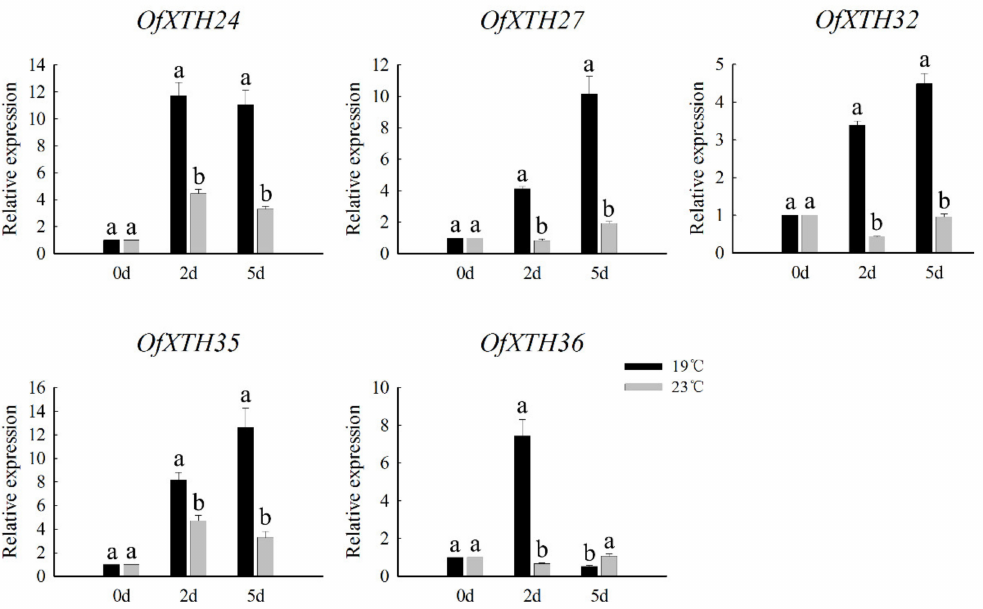
Figure 7. The qRT-PCR analysis of five differentially expressed OfXTH genes treated at 19 ◦ C and 23 ◦ C. Significant differences are identified by SPSS (version 22) with Duncan’s test ( p < 0.05) and are represented by different letters above the error